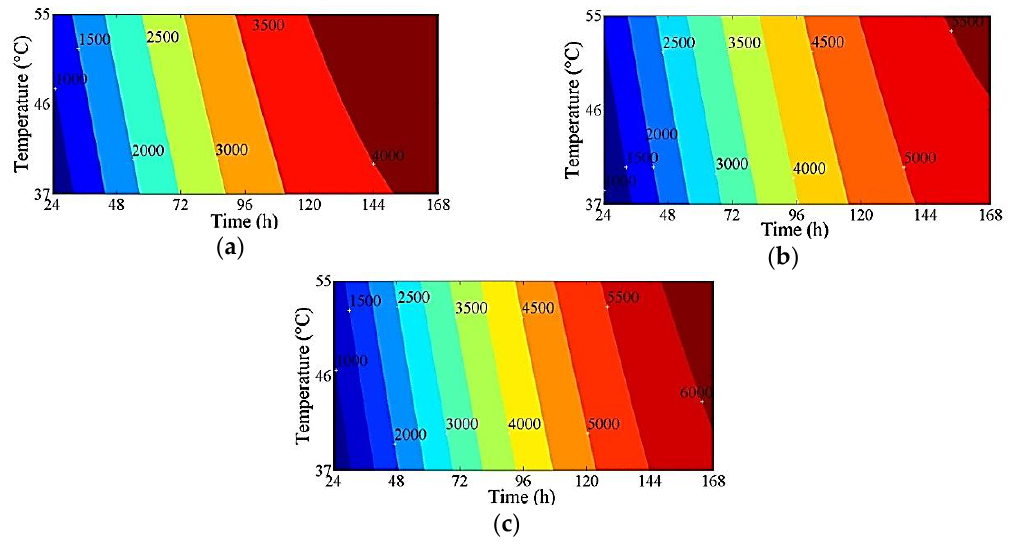
Figure 3. Modeled bio-hydrogen production: ( a ) mechanical pretreatment; ( b ) steam explosion; ( c ) chemical pretreatment.